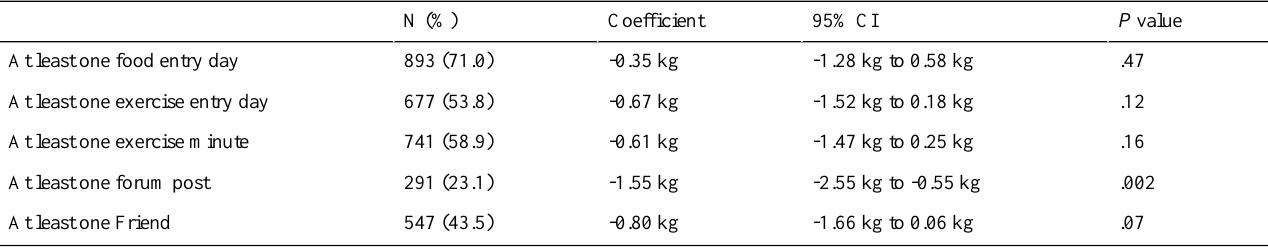
Table 4. Associations between website usage variables (binary) and weight change a in the final cohort